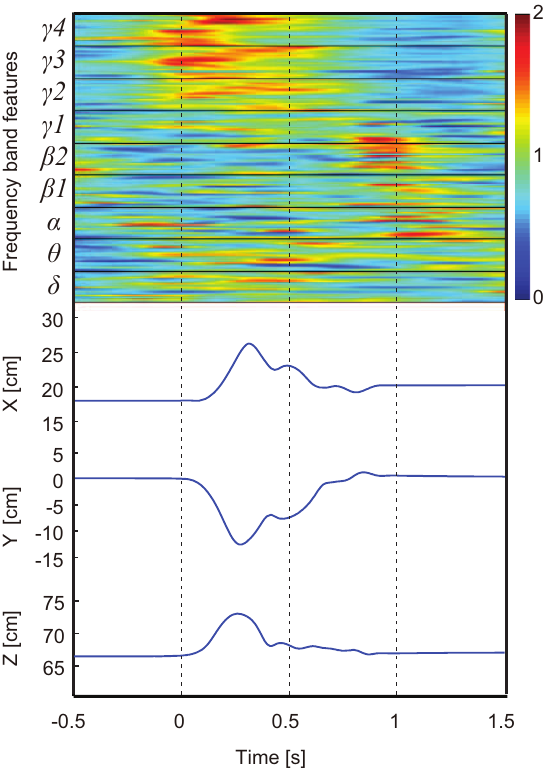
Figure 2. Example of measured trajectory and frequency band feature data during a movement task. Frequency band feature data were sorted into channels and frequency bands, as shown at the top. The X, Y, and Z positioning data recorded from the markers attached to the hand of monkey B, are shown at the bottom.